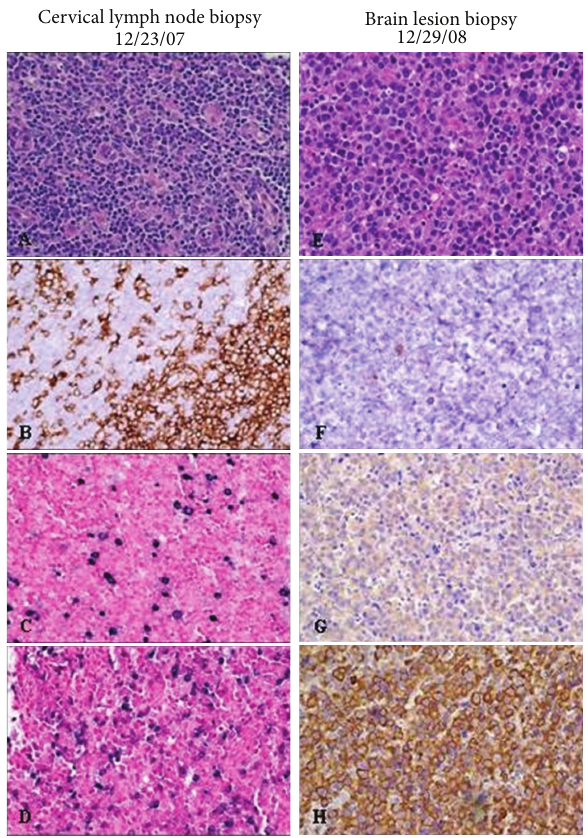
Figure 1: (A) Polymorphic PTLD. The nodal parenchyma is mostly effaced by a mixed population of small and large lymphocytes, immunoblasts, and plasma cells. (B) CD20 immunochemistry shows reactivity in residual follicles, as well as in scattered larger B cells outside of follicles. (C) In situ hybridization for kappa light chains shows scattered expression in plasma cells. (D) In situ hybridization for lambda light chains shows mild predominance of lambda expressing plasma cells over kappa. (E) Monomorphic PTLD: many cells resemble immunoblasts and plasmablasts with large nuclei, prominent nucleoli, and eccentric pink cytoplasm. (F) CD20 immunochemistry shows minimal expression, as CD20 is typically lost as B cells differentiate towards plasma cells. (G) Immunohistochemical stain for kappa light chains shows weak, nonspecific reactivity. (H) Immunohistochemical stain for lambda light chains shows strong cytoplasmic